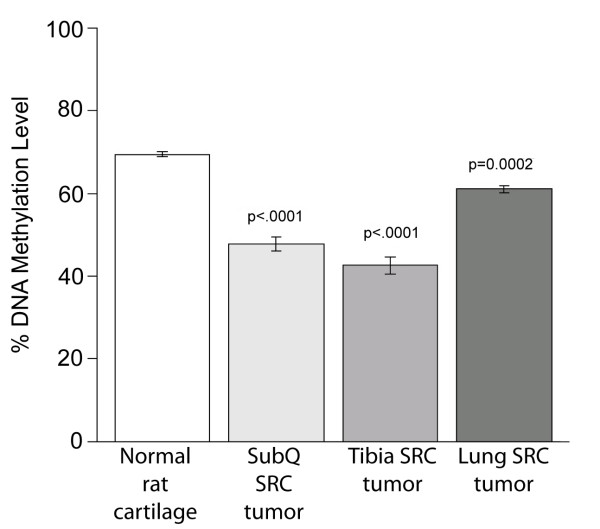
Transplantation microenvironment influences DNA methylation in SRC tumors. Pyrosequencing revealed that Satellite 1 DNA was hypomethylated compared to DNA from normal rat cartilage (control tissue). The satellite 1 DNA elements in the subcutaneous SRC tumor and the tibia SRC tumor were hypomethylated compared to the DNA in the lung SRC tumor. The graph illustrates the average Satellite 1 DNA methylation calculated from a pool of tissues from each transplantation site. For each transplantation site, tumor tissue was pooled from at least 10 separate animals. Bars represent the average DNA methylation % of technical replicates of the pooled tissue samples, and error bars represent the standard deviation of these replicates. P-values are indicated for comparisons between the specific sample and the "Normal rat cartilage" sample using Dunnett method in the analysis of variance (ANOVA). We attributed statistical significance to p values ≤ 0.05.